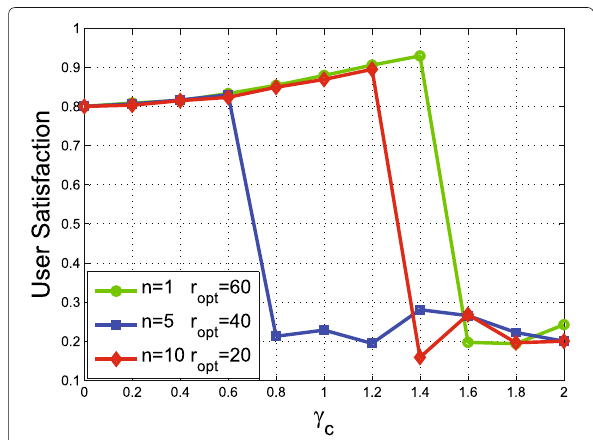
Fig. 14 The influence of γ c on user satisfaction under optimized distance. This figure shows the influence of related parameters on user